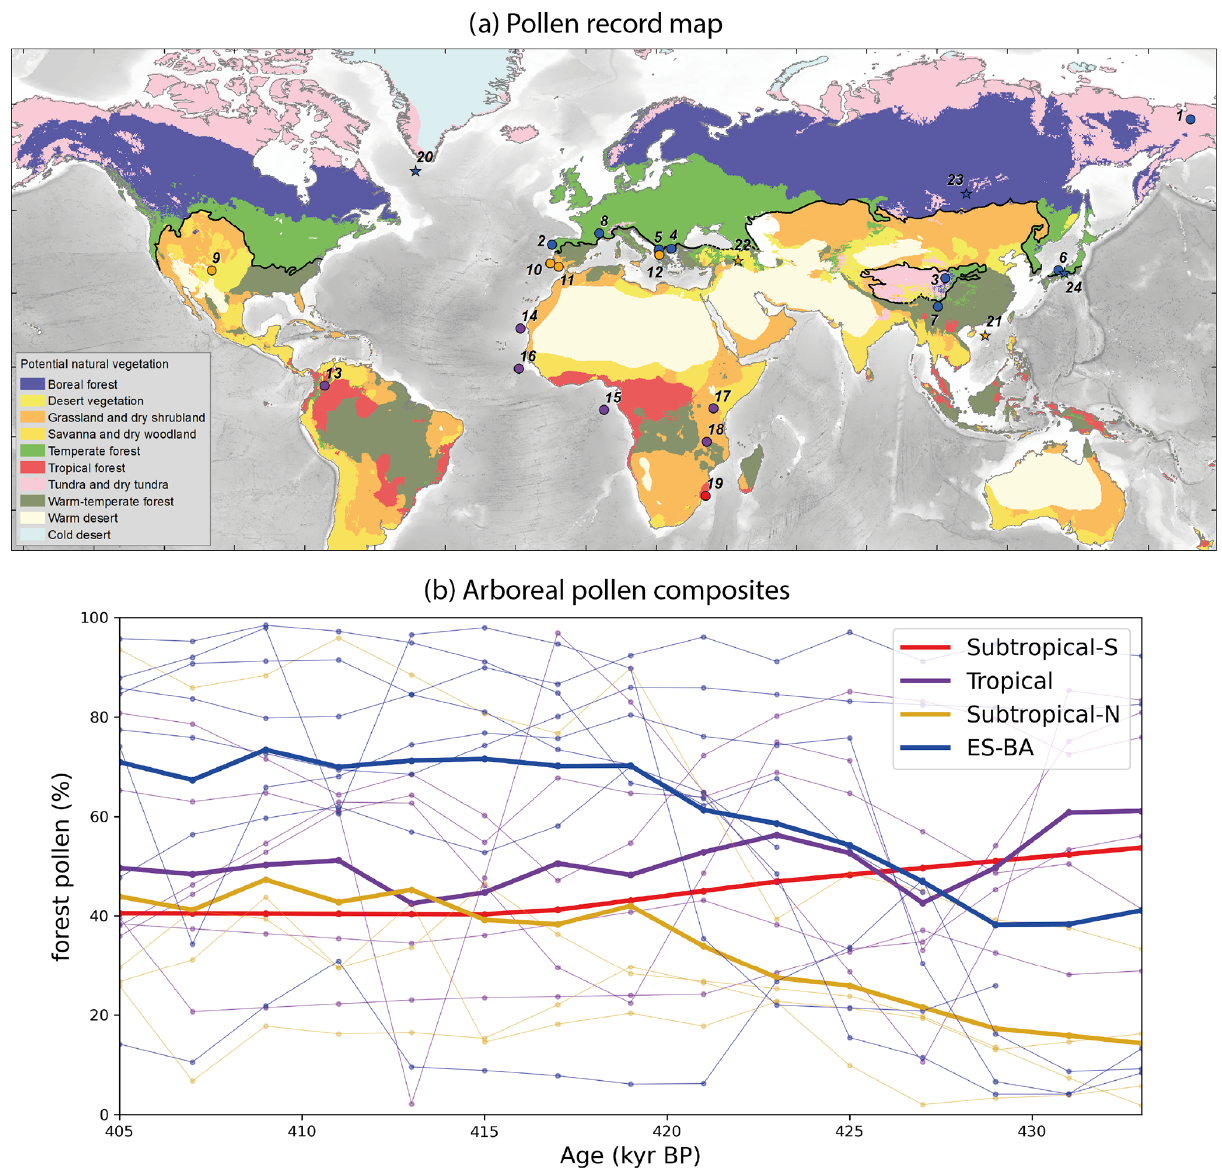
Figure 5. (a) Forest pollen record locations (dots, numbering refers to Table 2) classified into four bioclimatic groups defined in the text (red: Subtropical-S; purple: Tropical; yellow: Subtropical-N; blue: euro-Siberian–boreo-American, ES-BA). Stars refer to the pollen records covering TV and unavailable at the time of the study: numbers 20 to 24 correspond to sites ODP646 (de Vernal and Hillaire-Marcel, 2008), GeoB16602 (Cheng et al., 2018), Lake Van (Litt et al., 2014), Lake Baikal (Prokopenko et al., 2002) and Lake Biwa (Tarasov et al., 2011) respectively. Colour shading represents the modern biome distribution modelled by multinomial logistic regression (from Levavasseur et al., 2012) on the BIOME 6000 database (Prentice et al., 1996; Pickett et al., 2004) and the black line delineates the ES-BA megabiome southern boundary (courtesy of Vincent Hanquiez). (b) Record time series with colours referring to the same bioclimatic groups as in (a) . Pale lines represent the individual forest pollen records and bold lines the forest pollen composite for each